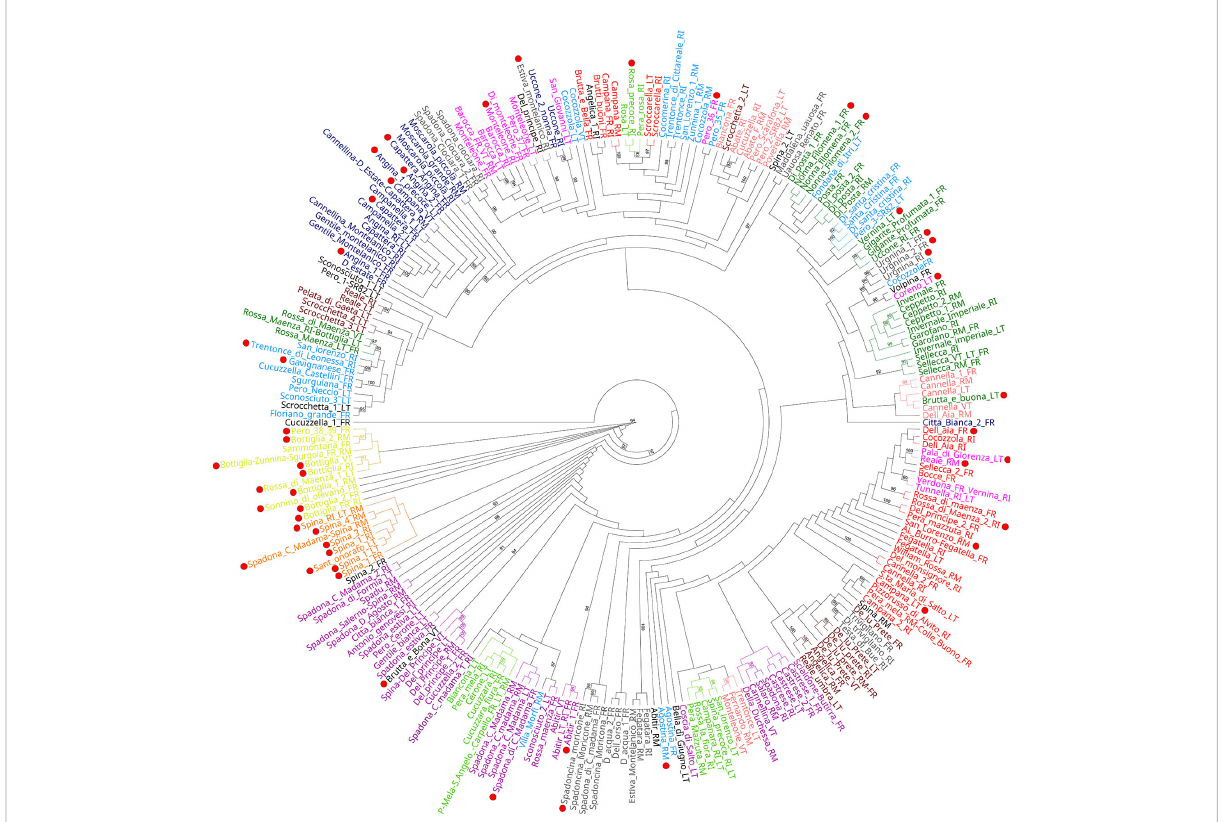
FIGURE 4 Maximum likelihood dendrogram topology representing the genetic relationships among the different genotypes. Bootstrap values ( ≥ 90) are highlighted to support the branches on the dendrogram, and red dots indicate accessions with two or more loci with a third